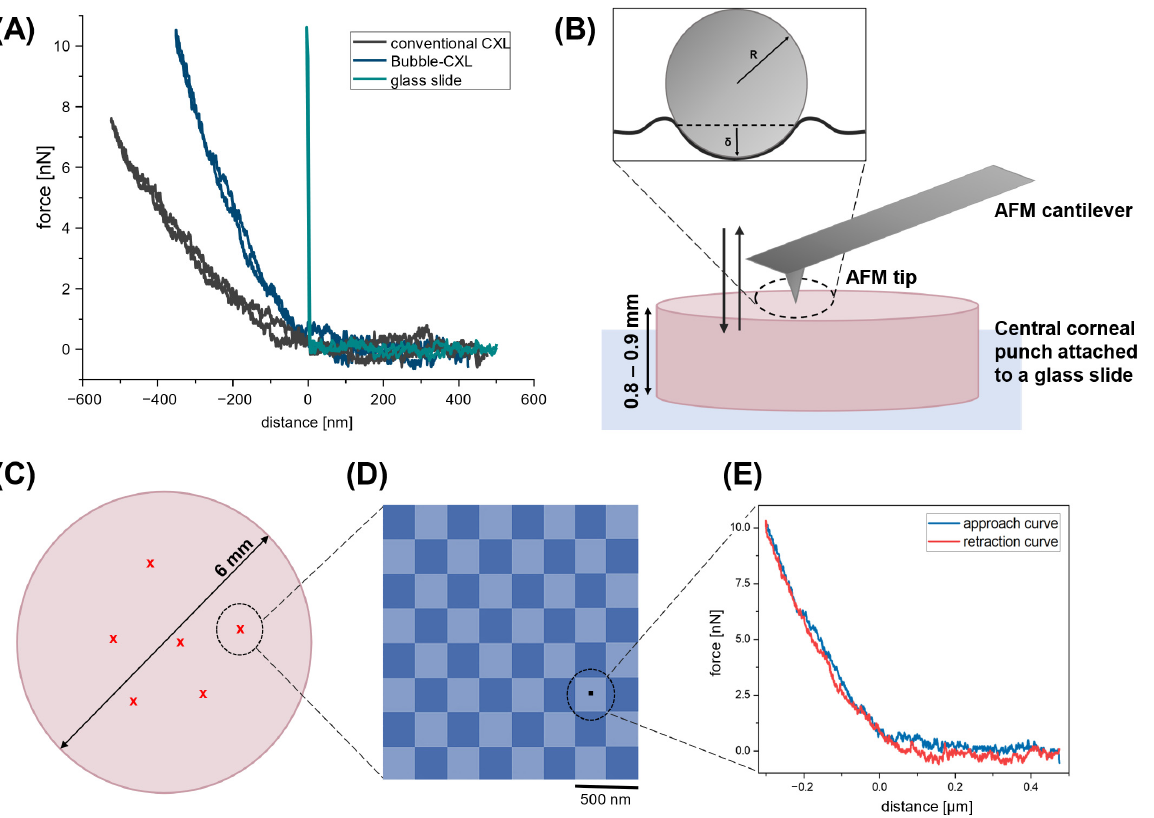
Figure 2. ( A ) Force–distance curves recorded in AFM force spectroscopy: the indentation of the AFM tip into the cornea sample is recorded by the deflection of the AFM cantilever, visible in a non-linear indentation curve. No indentation of the AFM tip was observed on a rigid glass substrate, whereas the indentation depth δ is measurable on softer samples. ( B ) For AFM indentation experiments, the cornea sample was attached to a glass substrate, and force–distance curves were recorded by indenting the parabolic part of the tip into the sample. An elastic half-space is assumed for small indentation forces, and the indentation depth δ depends on the sample stiffness. ( C ) Measurements were performed on different positions on the cornea surface, ( D ) on each position, 8 × 8 force–distance curves were recorded within an area of 4 µ m 2 . ( E ) The indentation part of the approach curve (blue, − 0.3 µ m to 0 µ m) was further analyzed for Young’s modulus